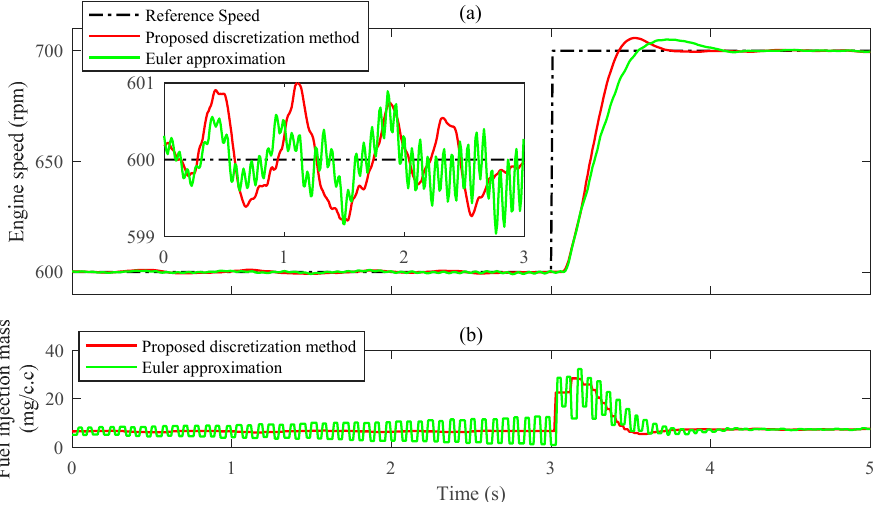
Figure 6. The control performance comparison of different discretization methods for ADRC with variable sampling rate at low speed region: ( a ) The speed response; ( b ) The control input.